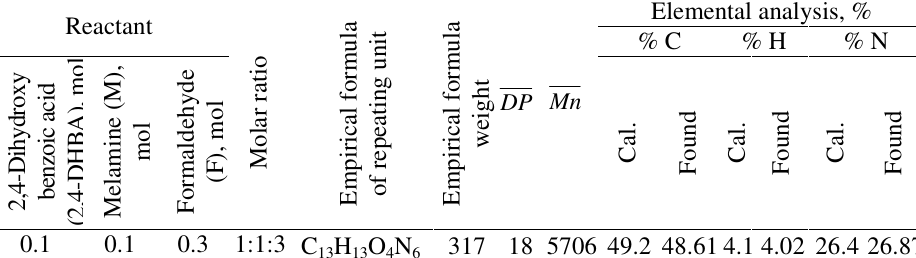
Elemental analysis, %